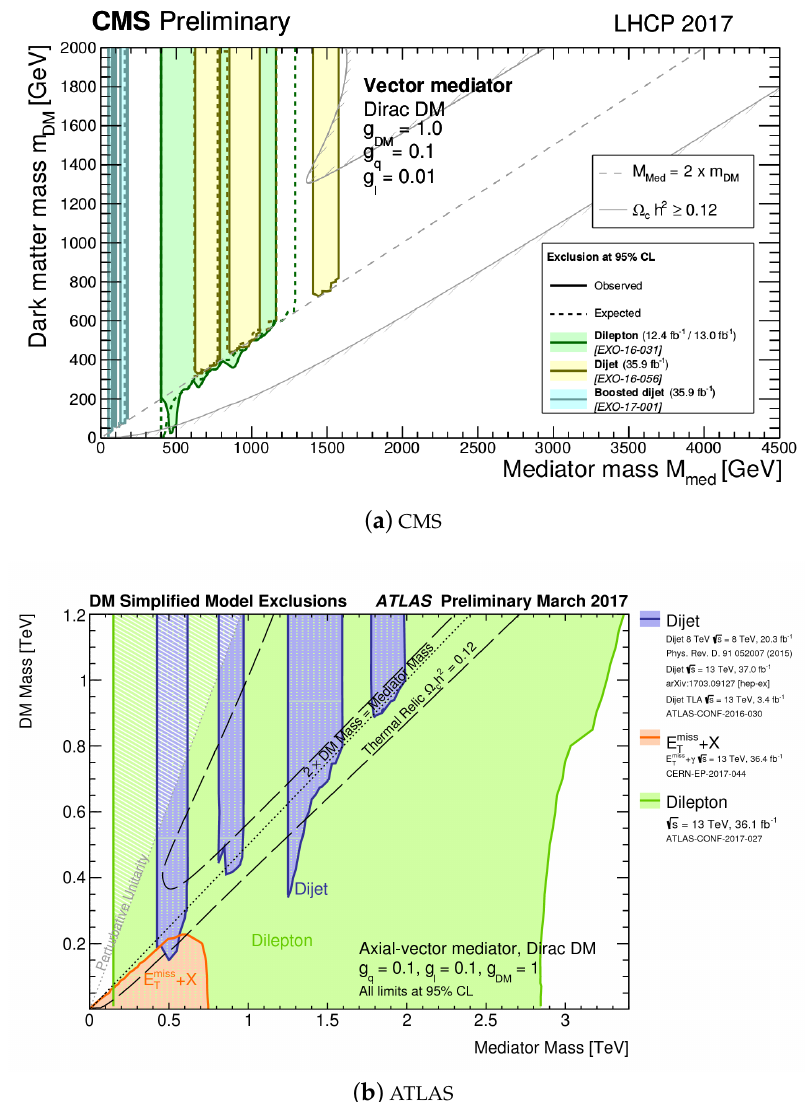
Figure 15. Summary plots for the CMS [27] ( a ) and ATLAS [28] ( b ) dark matter searches. The coupling of the mediator to DM (g DM ) is set to one, to quarks (g q ) to 0.1, and to leptons (g (cid:96) ) to 0.1 (0.01 for CMS). The CMS results refer to the vector-mediator interpretation and the ATLAS results to the axial-vector